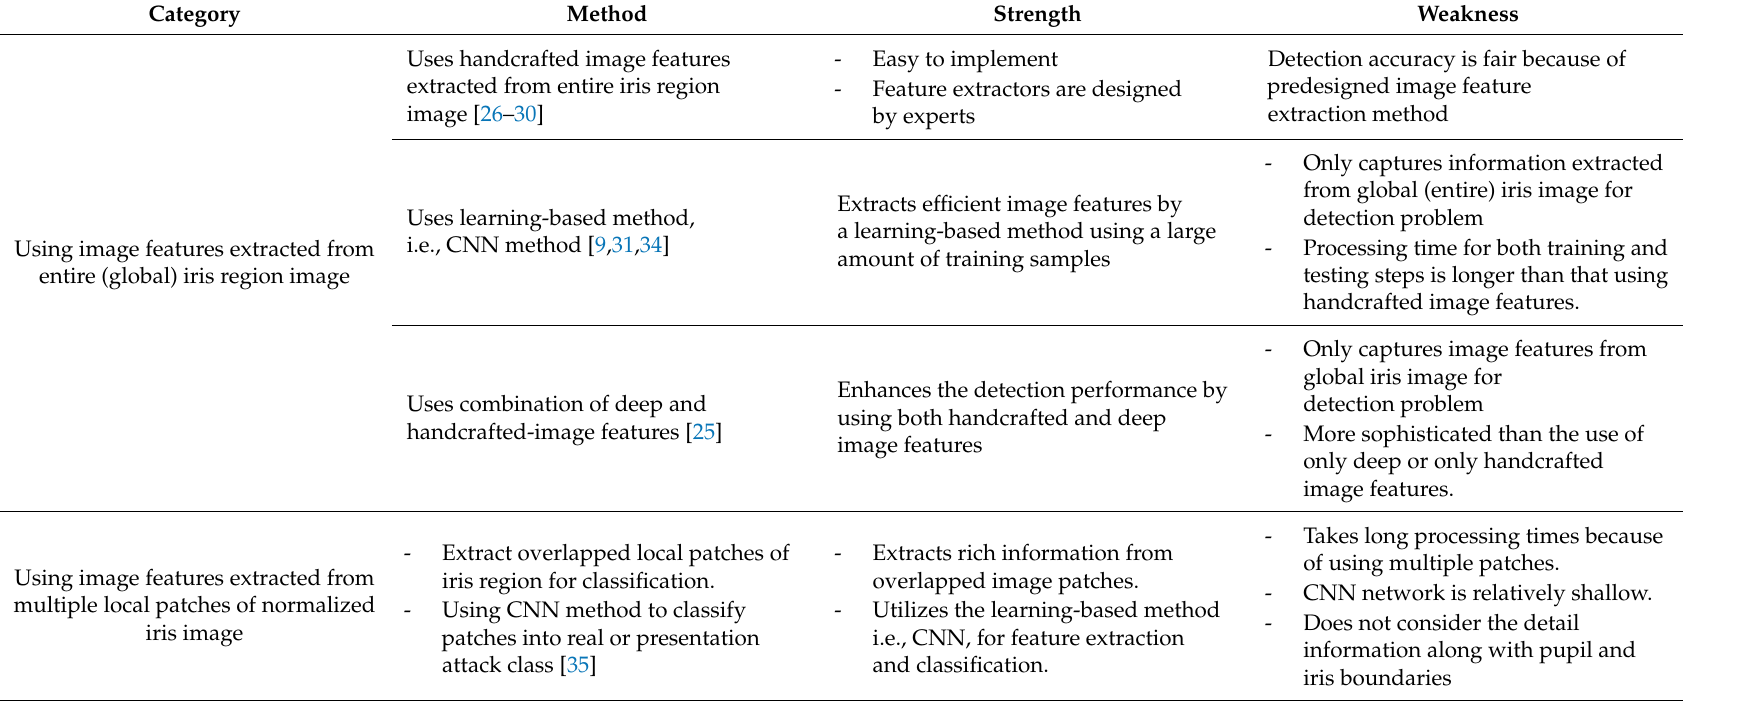
Table 1. Summary of previous studies on iPAD compared to our proposed